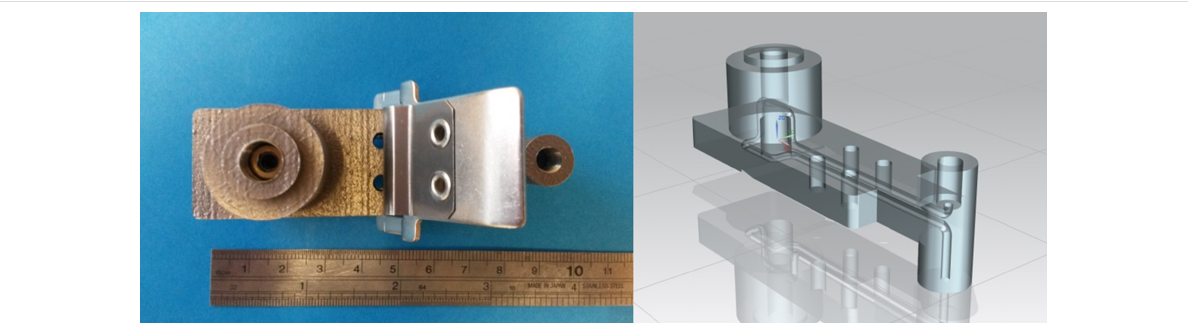
Figure 10: SLM reactor design RD3 (left), CAD model of RD3 (right). External dimensions of RD3 are 89 (length) × 27 (width) × 38 mm (depth).